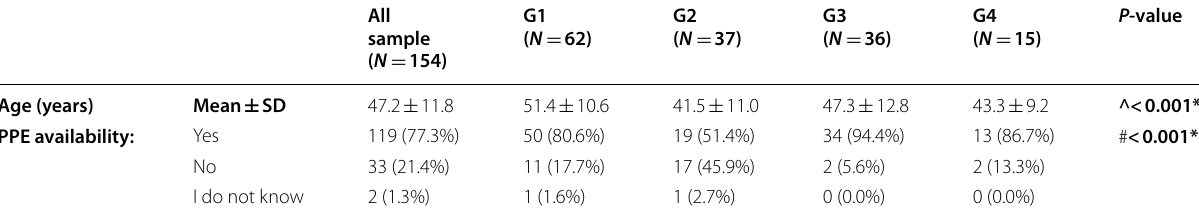
Table 1 Participants’ age and availability of PPE in their health care facilities